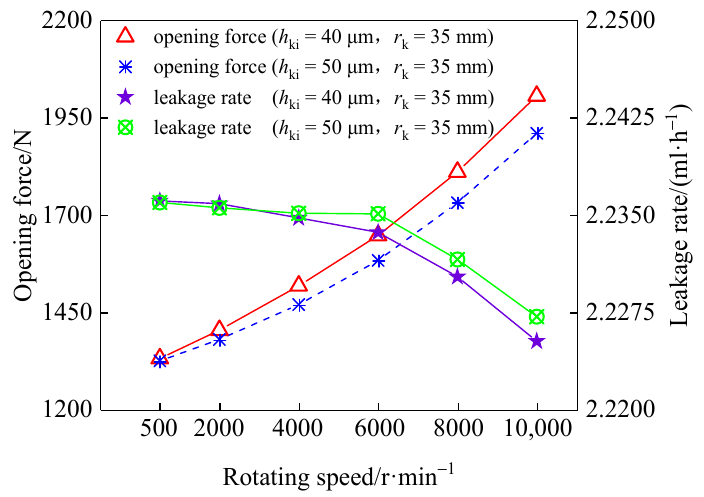
Figure 16. Influence of the rotating speed on the sealing performance. ( h ki = h g = 50 µ m, r o = 30.6 mm, γ = 0.6, N g = 32, α =3 4°, λ = 0.9, Δ p = 0.5 MPa).